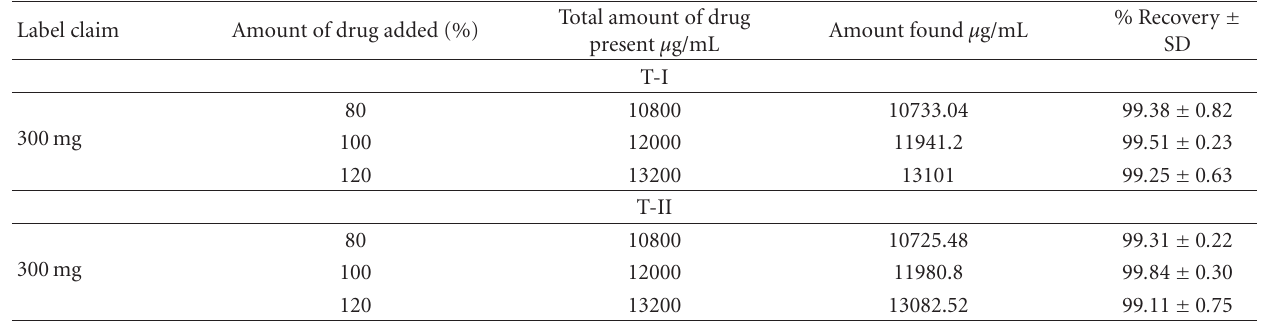
Table 4: Recovery studies a .